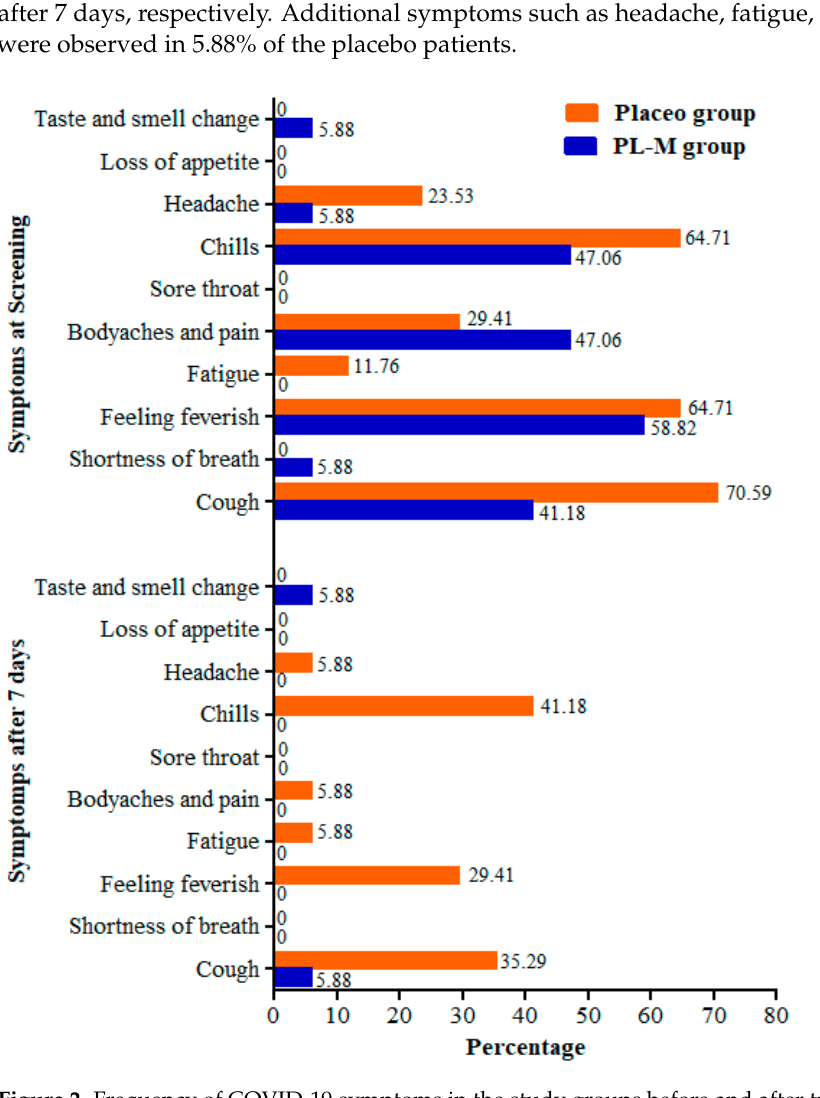
Figure 2. Frequency of COVID-19 symptoms in the study groups before and after